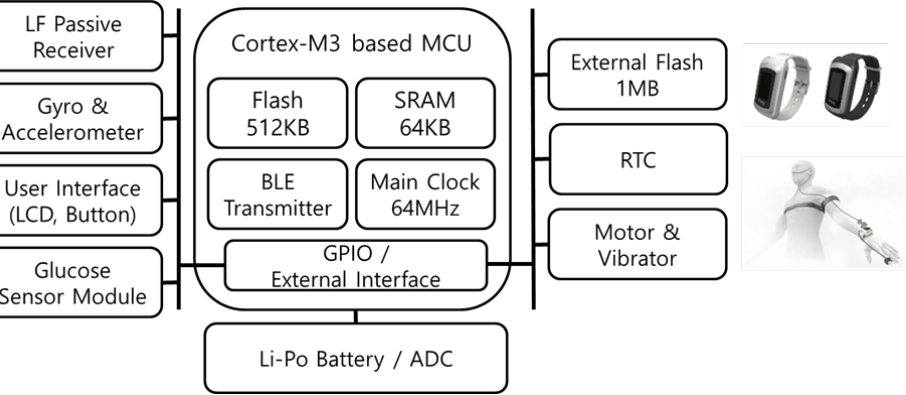
Figure 5. Hardware Block Diagram of Mobile Identification Device.